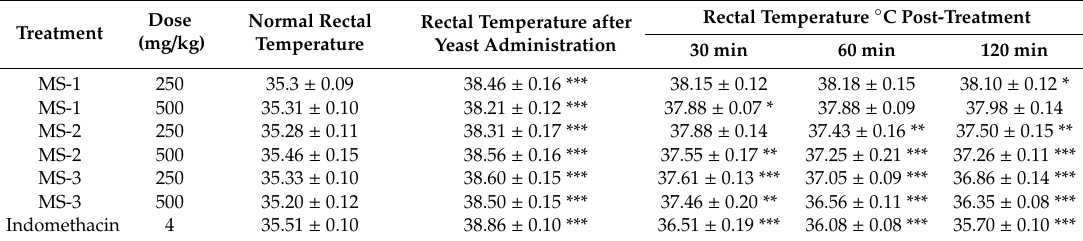
Table 6. E ff ects of M. sinaica and fractions on yeast-induced hyperthermia in mice. Treatment